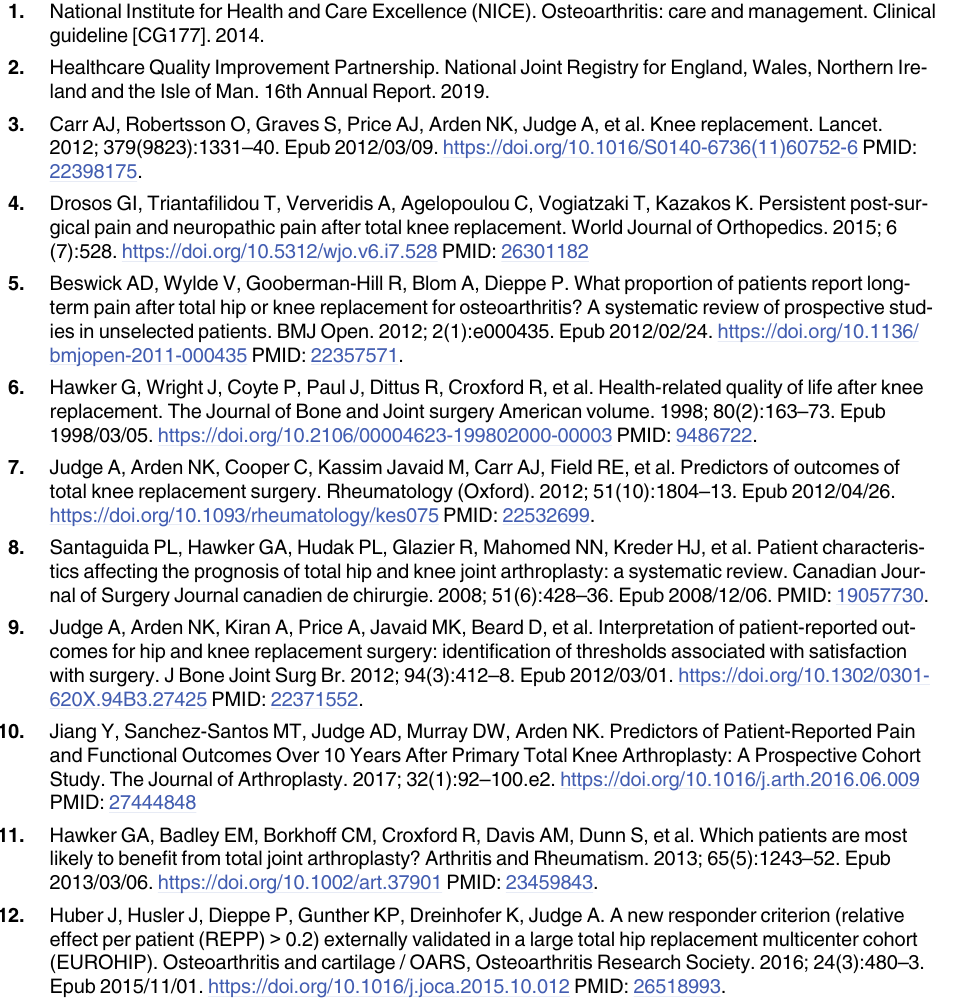
S1 Fig. Receiver operating characteristic curve (ROC) curve for discriminatory ability of variables in the final